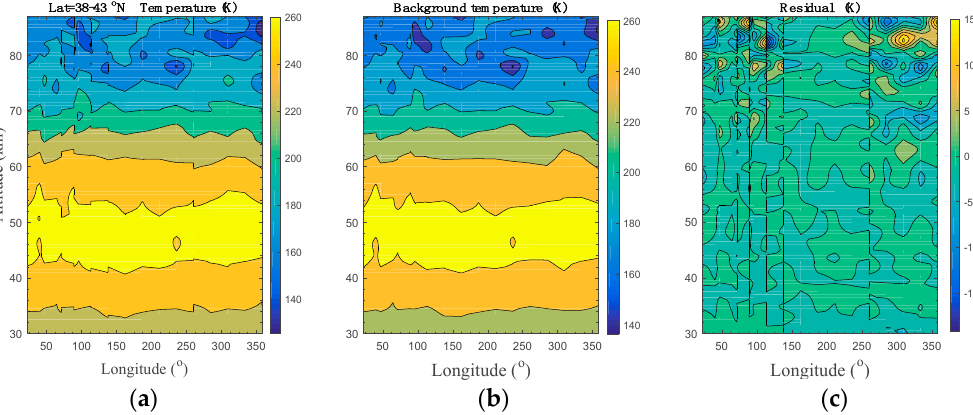
Figure 6. TIMED/SABER measurement results on 30 May 2012. ( a ) Temperature structure observed in the latitude range of 38–43° N. ( b ) Background temperature obtained by the least square harmonic fitting with zonal wavenumbers from 0 to 7. ( c ) Residual (temperature perturbation) obtained by subtracting the fitted background temperature from the observed temperature.